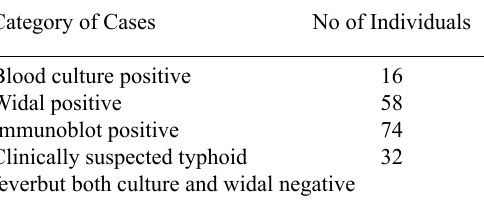
Table 1. Category of cases